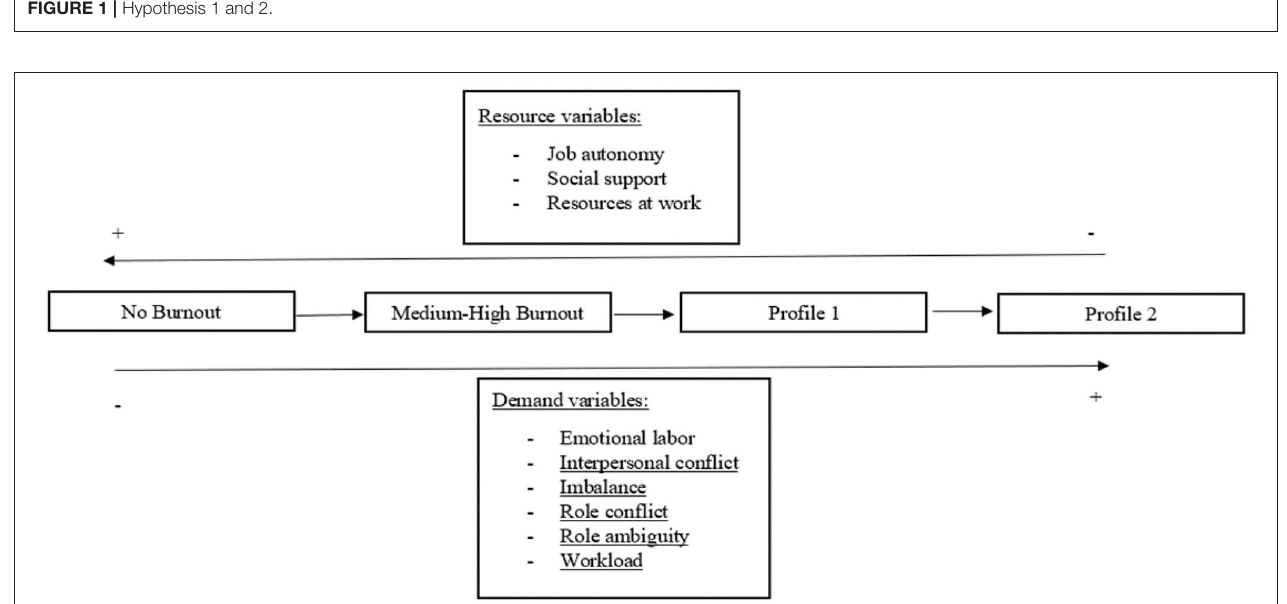
FIGURE 2 | Hypothesis